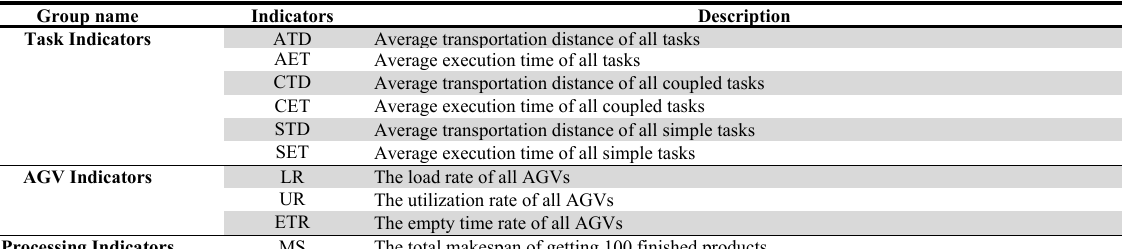
The utilization rate of all AGVs ETR The empty time rate of all AGVs Processing Indicators MS The total makespan of getting 100 finished products